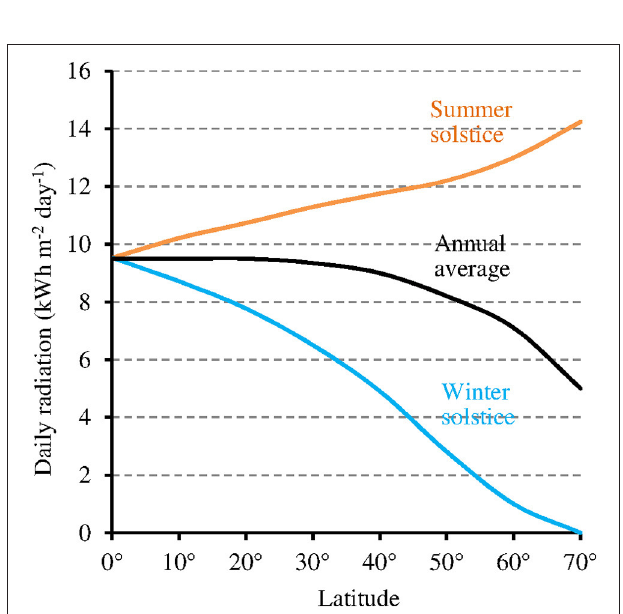
FIGURE 6 | Relation between latitude and total daily radiation under clear sky (annual average and at the two solstices of the year) (source: pvlighthouse, http://pveducation.org/pvcdrom/calculation-of-solar-insolation). latitudes (between 58 ◦ and 68 ◦ N at about 15 ◦ of longitude